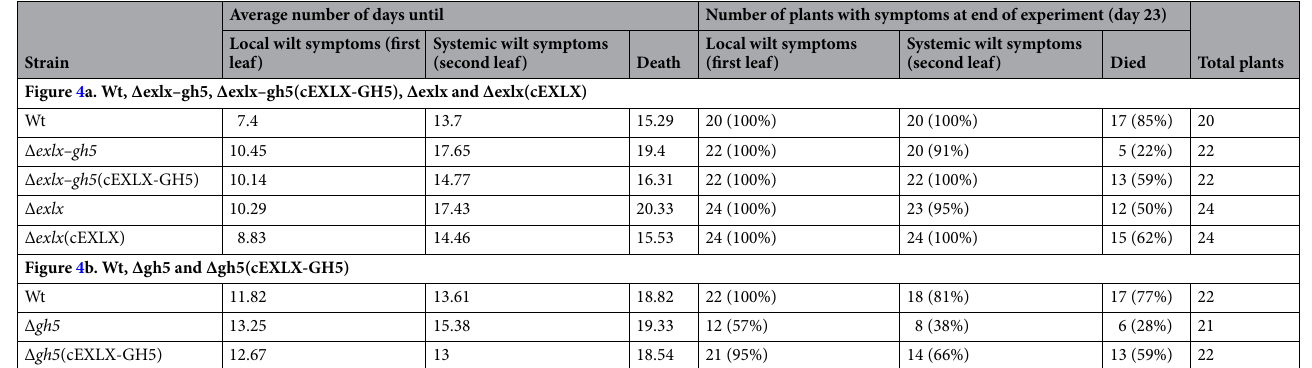
Table 1. Summary of in planta inoculation experiments comparing virulence between strains Wt, Δ exlx– gh5 , Δ exlx–gh5 (cEXLX-GH5), Δ exlx and Δ exlx (cEXLX) (Fig. 4a); and between strains Wt, Δ gh5 and Δ gh5 (cEXLX-GH5) (Fig. 4b).